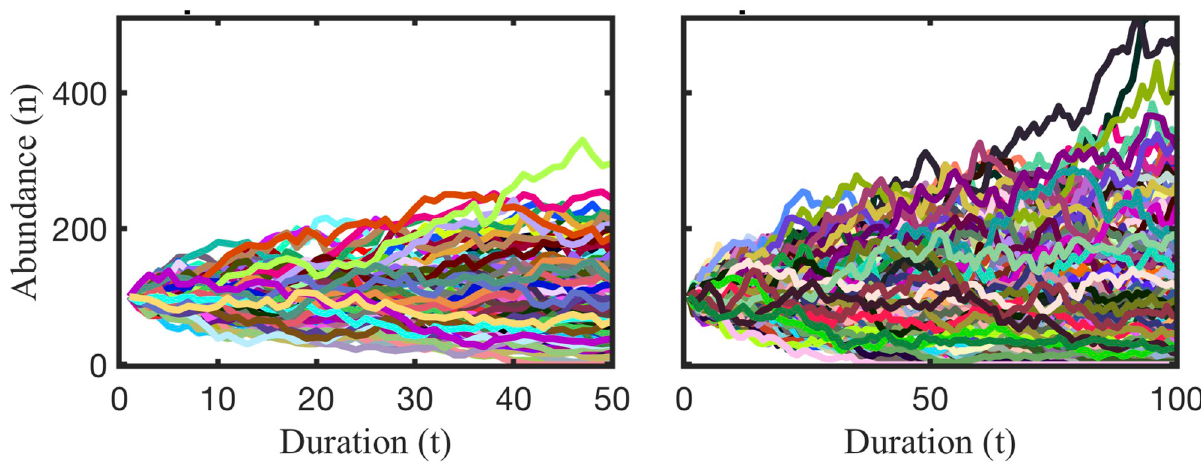
Fig 9. For phenotypically heterogeneous populations, an unlimited number can co-exist. Abundance of 101 (left) and 301 (right) equilibrium strategies in 50 to 100 rounds of competition. Although abundance fluctuates over time and no one population dominates, there are less than a handful of observable extinctions. The number of co-existing species displayed is limited by CPUs and visibility. Theoretically, the number is infinite.